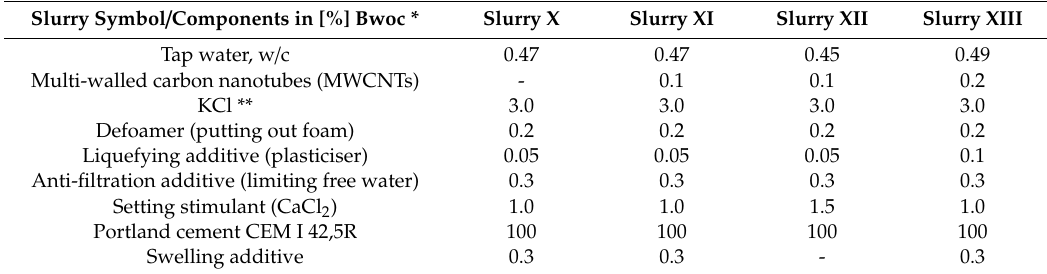
Figure 8. ( a ). Sample microstructure of “conventional” cement slurry (with no addition of n-Al 2 O 3 ). Magnification 500×. ( b ). Sample microstructure of “conventional” cement slurry (with no addition of n-Al 2 O 3 ). Magnification 1300×. Table 8. Compositions of tested cement slurries with an addition of